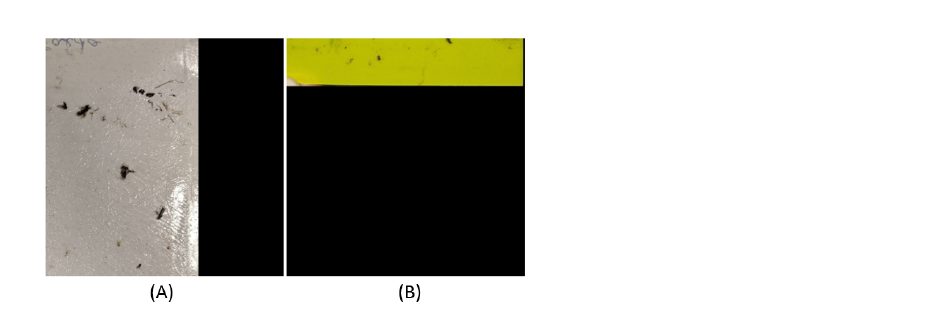
Figure 6. Examples of down-sampling empty patches: ( A ) patch kept; and ( B ) patch removed.